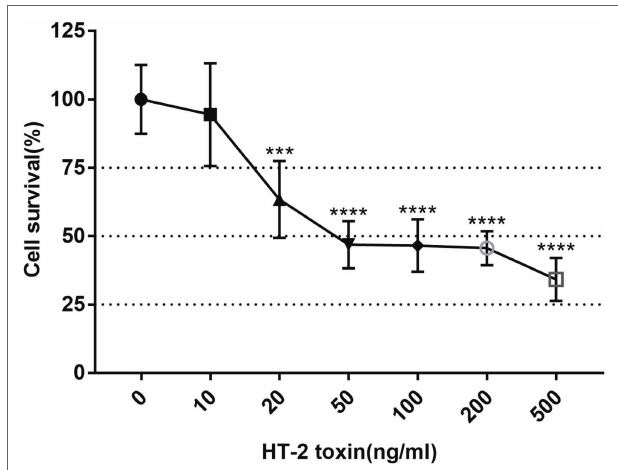
FIGURE 3 | Cell viability of the KBD hiPSC chondrocytes after 7-day exposure of HT-2 toxin. Reported values are the mean ± SD of three independent experiments. *** p < 0.001, a significant difference between the treatment and control group (0 ng/ml); **** p < 0.0001; n = 3. KBD, Kashin–Beck disease; hiPSCs, human induced pluripotent stem